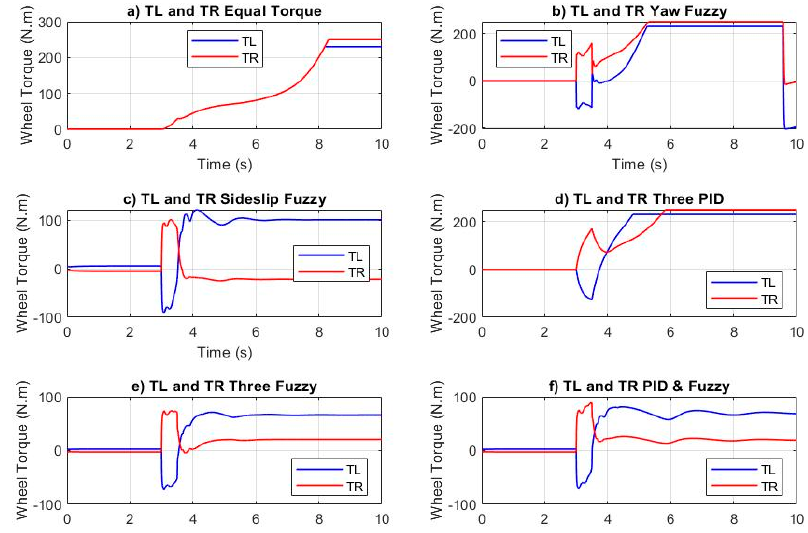
Figure 8. Torque input of the driving right and left rear wheels: ( a ): Equal torque controller, ( b ): Yaw rate fuzzy controller, ( c ): Sideslip angle fuzzy controller, ( d ): Three PID controllers, ( e ): Three fuzzy controllers, ( f ): Fuzzy and PID controllers.